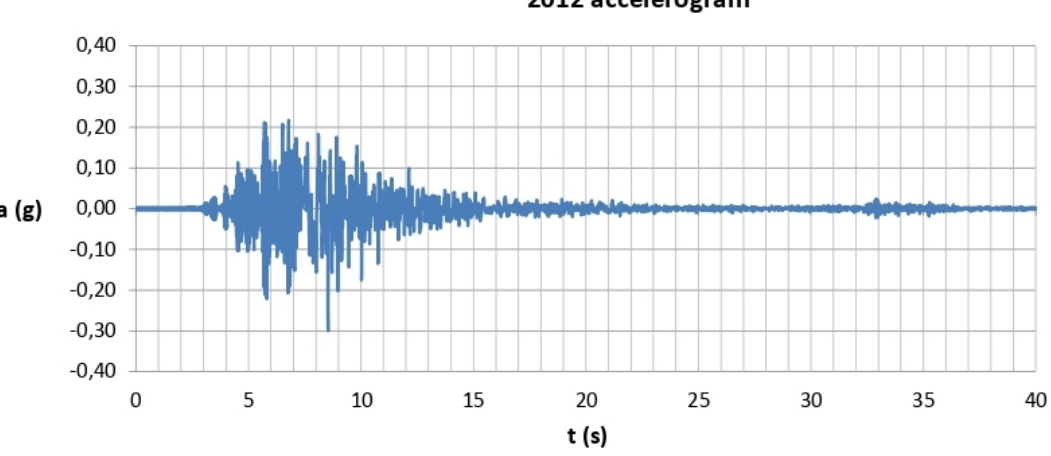
Figure 22. Accelerogram recorded at Sortino during the earthquake on 13 December 1990 [53].